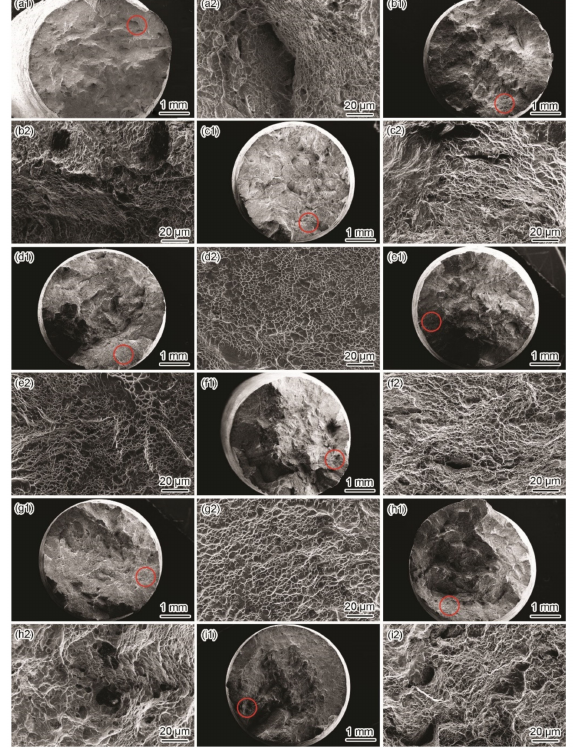
Figure 9. Fracture surface morphologies in a simulated shallow − sea environment. Macromorphology of fracture surface at − 1.5 V ( a1 ), − 1.3 V ( b1 ), − 1 V ( c1 ), − 0.8 V ( d1 ), − 0.6 V ( e1 ), − 0.15 V ( f1 ), E corr ( g1 ), 0.8 V ( h1 ), and 1.5 V ( i1 ); micromorphology at crack initiation site marked with red circle in ( a1 – i1 ) at − 1.5 V ( a2 ), − 1.3 V ( b2 ), − 1 V ( c2 ), − 0.8 V ( d2 ), − 0.6 V ( e2 ), − 0.15 V ( f2 ), E corr ( g2 ), 0.8 V ( h2 ), and 1.5 V ( i2 ).